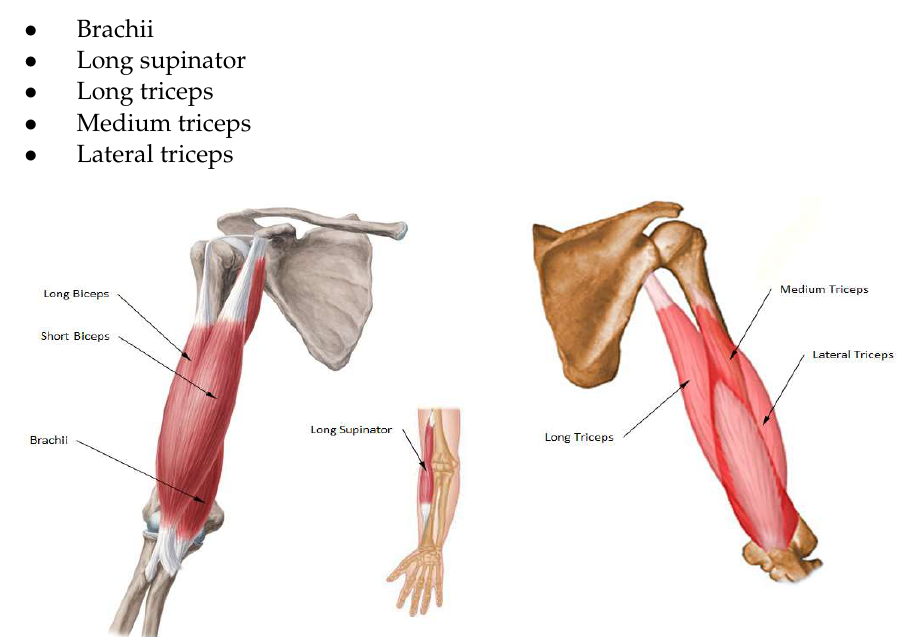
Figure 1. Flexors ( left ) and extensors ( right ) elbow muscles identification.